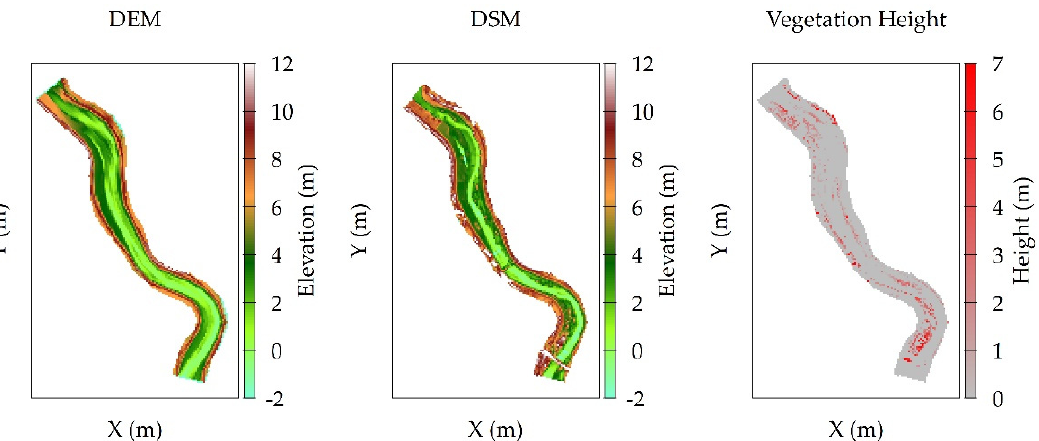
Figure 5. Image of the DEM ( left ), DSM ( center ), and vegetation height ( right ); vegetation height is the result of DSM–DEM for the vegetated grid cells.